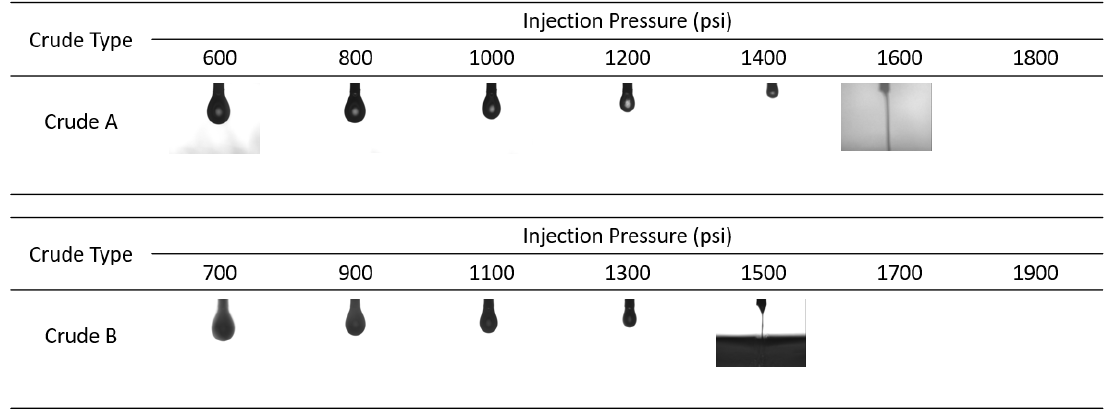
B without additives, i.e., pure CO 2 and the specific oil. 208